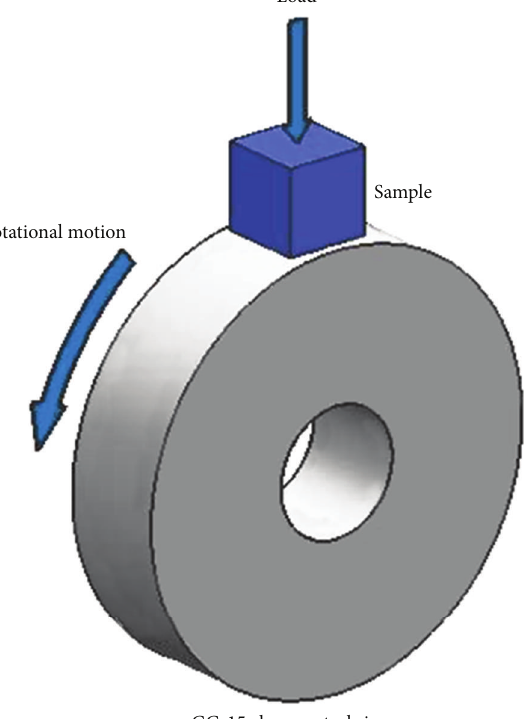
Figure 1: Schematic illustration of the wear test device.